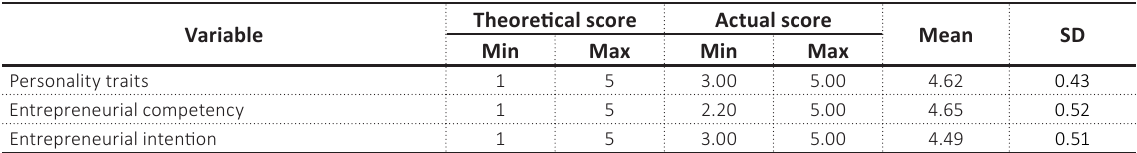
Table 1. Descriptive statistics of variables